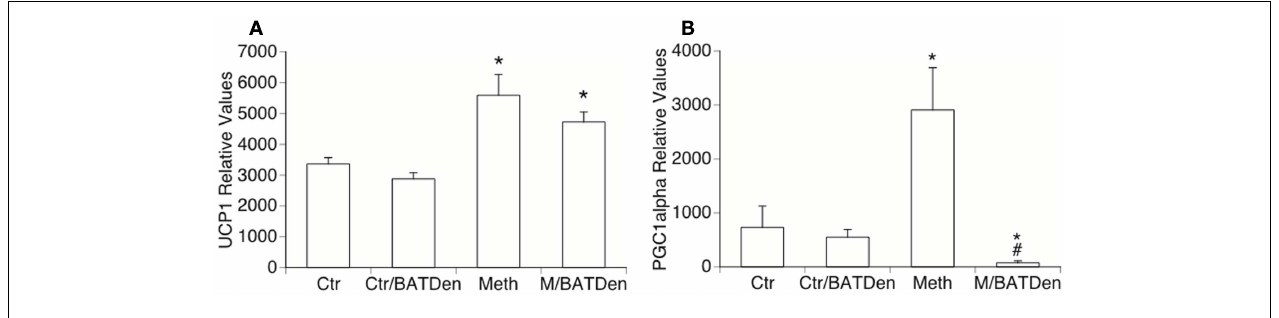
on GAPDH.Values represent the average ± SEM of six animals/group. * p < 0.05 Compared to respective controls, # p < 0.05 compared to Meth alone.